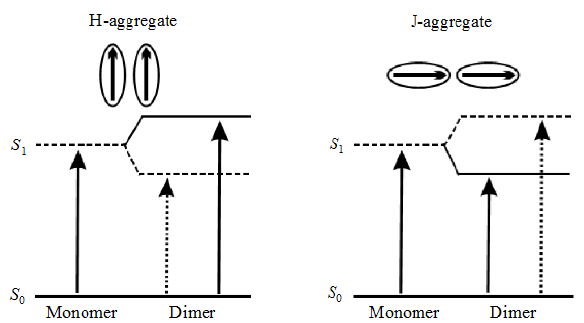
Fig. 5 H-aggregate, J-aggregate, and corresponding energy levels.